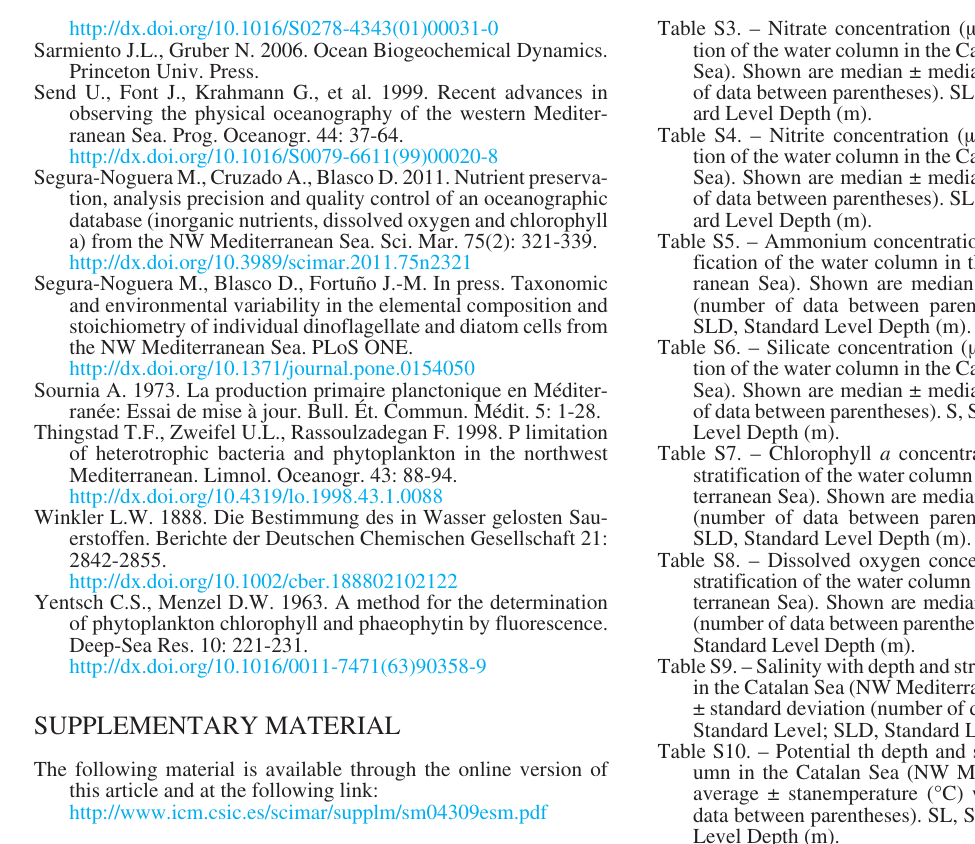
Table S1. – Detailed list of the cruises used in this study, including the year, the maximum depth sampled (z max), the number of profiles (n), th ebiogeochemical variables available (shaded), and the source of the data. Table S2. – Phosphate concentration (µM) with depth and stratifica- tion of the water column in the Catalan Sea (NW Mediterranean Sea). Shown are median ± median absolute deviation (number of data between parentheses). SL, Standard Level; SLD, Stand- ard Level Depth (m).